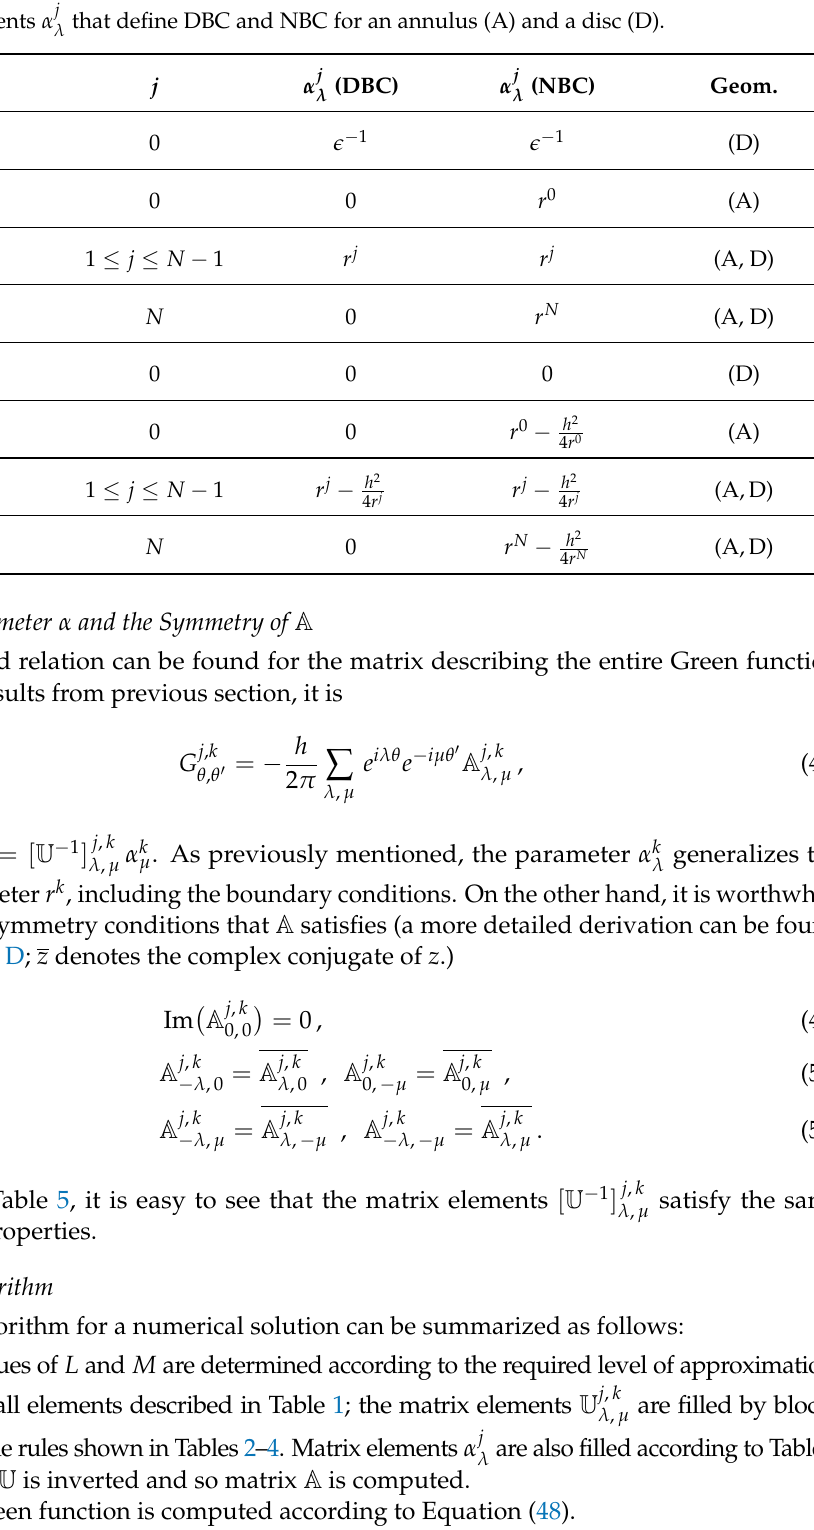
Table 5. Elements α j